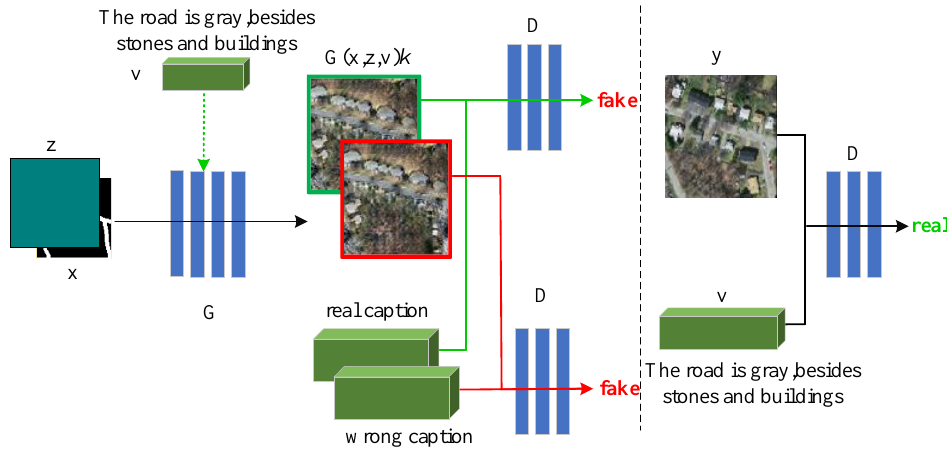
Figure 4. BTD-sGAN training